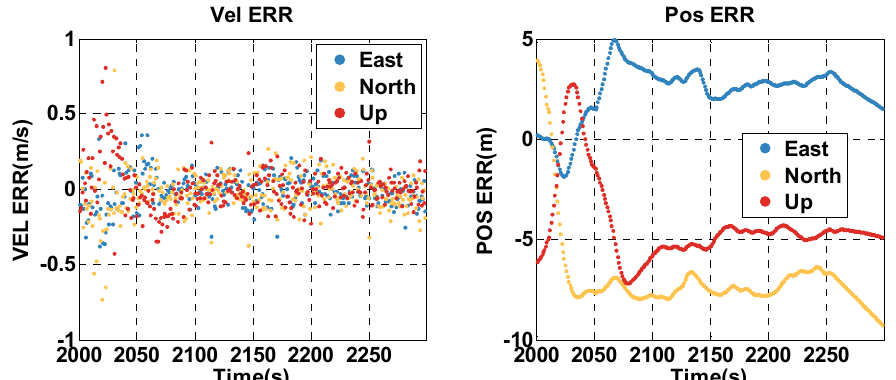
Figure 15. The position and velocity errors of the MTF method in the insufficient satellite case.